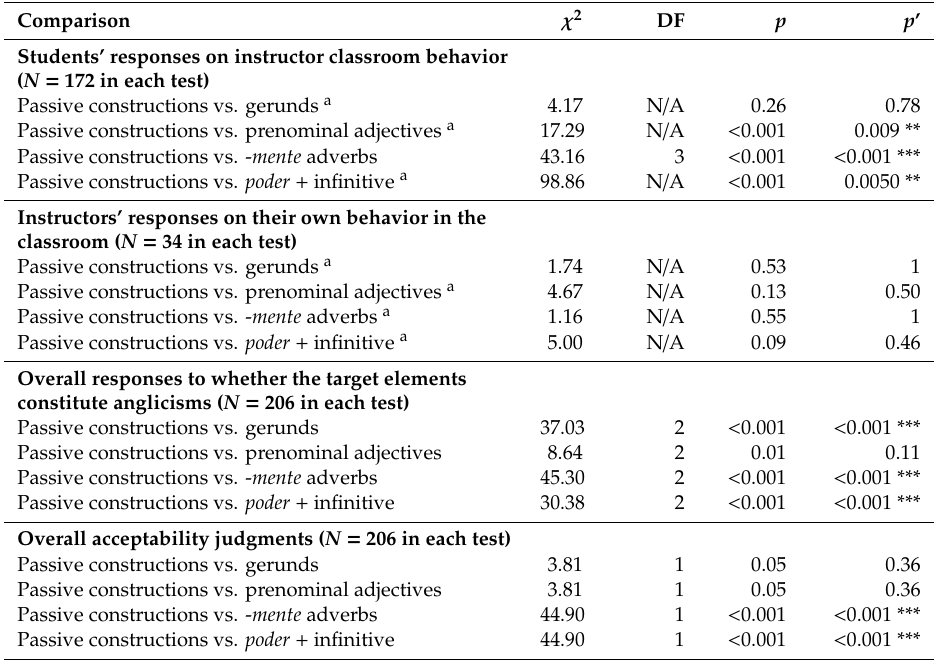
Table 8. Post-hoc comparisons between responses for passive constructions and responses for the other